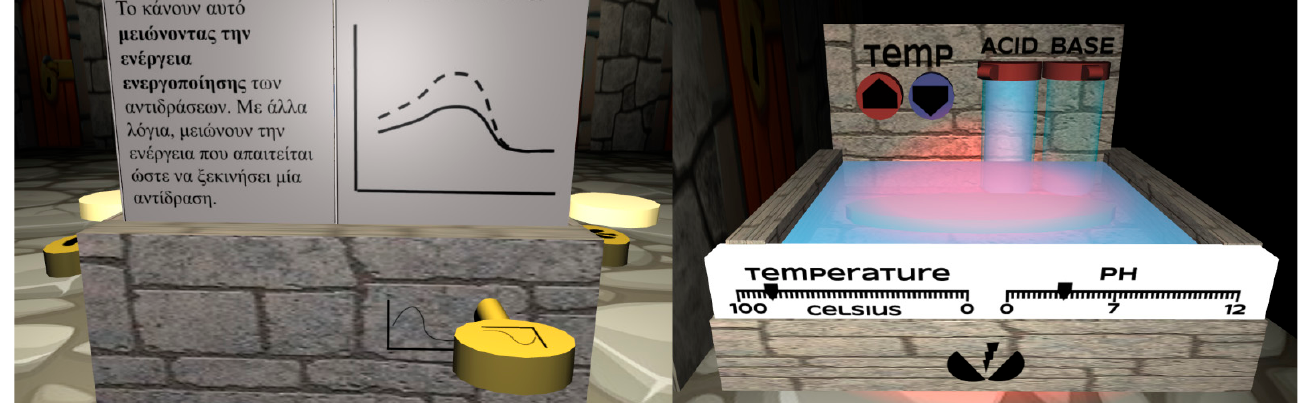
Figure 1. Snapshots of the virtual reality escape room; presentation of information in Greek regarding the function of the enzymes: “enzymes work by making it easier for a reaction to happen and therefore, the reaction happens at a faster rate. They do this by lowering the activation energy of the reaction, or how much energy it takes to get the reaction going”. ( left ) Knowledge application puzzle on enzyme denaturing by maintaining an optimal temperature and pH ( right ).